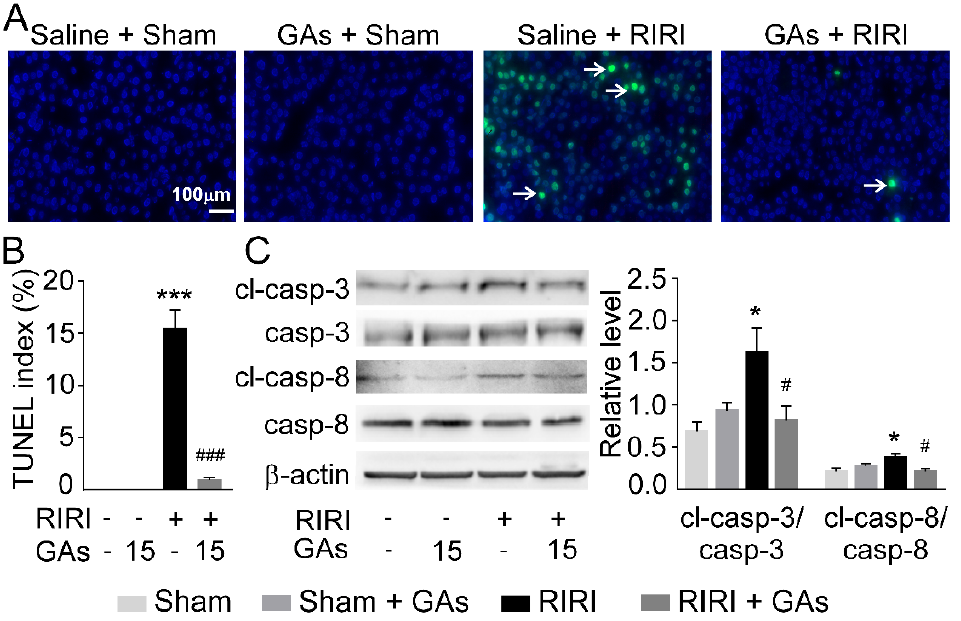
Figure 4. GAs inhibited RIRI-mediated apoptosis in mice. ( A ) Representative TUNEL staining (green fluorescence, magnification 200 × ) and ( B ) TUNEL-positive index ( n = 8). ( C ) Representative Western blots and the relative protein levels of cleaved caspase-3, caspase-3, cleaved caspase-8 and caspase-8 in the kidney. The data of target proteins are expressed relative to the intensity of the Saline + Sham group. Values are expressed as the mean ± SEM ( n = 6). * p < 0.05 and *** p < 0.001 compared with Saline + Sham group; # p < 0.05 and ### p < 0.001 compared with Saline + RIRI group (two-tailed Student’s t -test or one-way